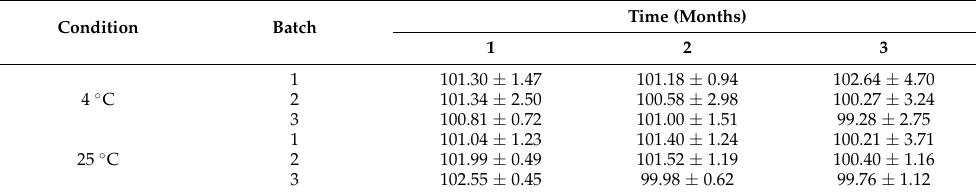
Table 1. The stability of the MXD-TG at 4 ◦ C and 25 ◦ C for three months (%).